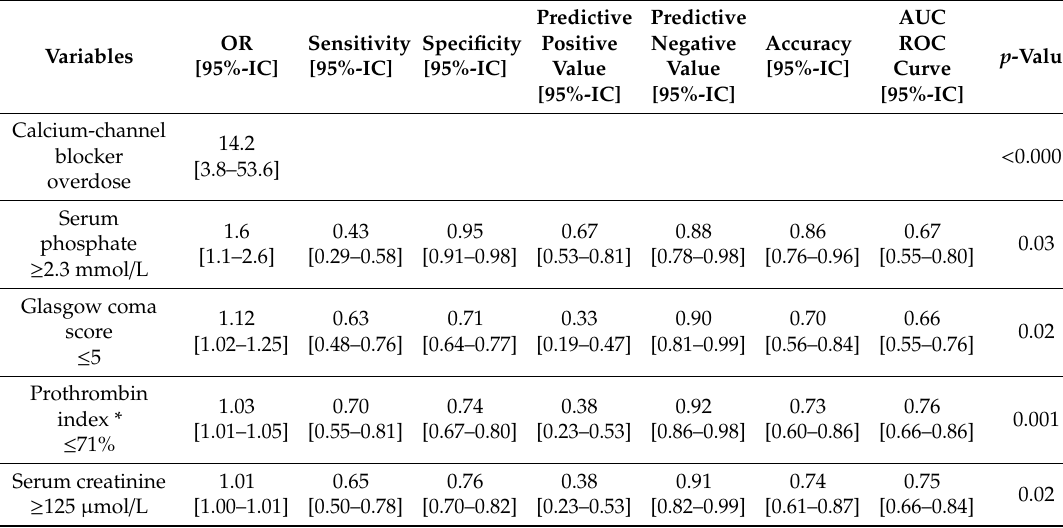
Table 7. Variables on intensive care unit admission significantly associated with the requirement of renal replacement therapy in the poisoned patient with rhabdomyolysis based on a multivariate logistic regression